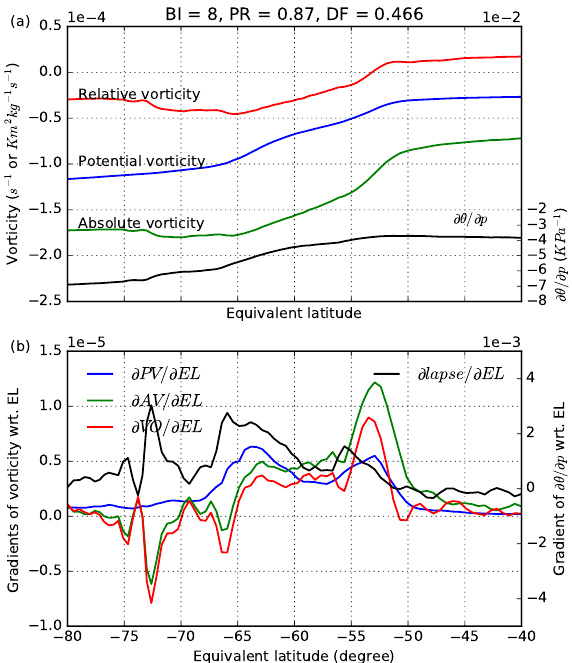
Figure 9. Example meridional profile of (a) absolute (AV; green line; s − 1 ), relative vorticity (VO; red line; s − 1 ), and PV (blue line; Km 2 kg − 1 s − 1 ) on the left axis and static stability (black line; KPa − 1 ) on the right axis, and (b) gradients with respect to EL ( ∂ PV /∂ EL (sPVU ◦− 1 )). All lines are averages at EL calculated from PV. This example is from 530K on 1 September 2011 in ERA-